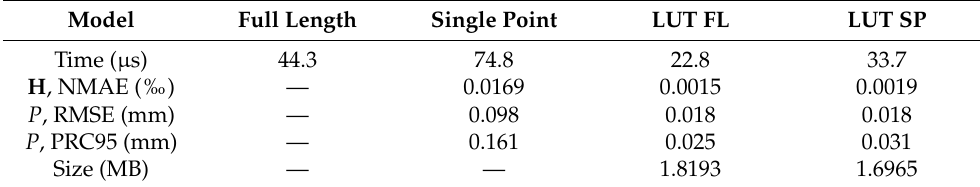
Table 1. Model comparison, based on a simulation of a 10mm-long sensor placed at 100,000 random positions and orientations within the tracking region. The normalised mean absolute error (NMAE) of the magnetic field, H , is averaged between the eight equal emitter coils, and the associated error in terms of position accuracy, P , is reported. The error introduced by the single-point approximation is calculated with respect to the full-length model. Each LUT is evaluated against the correspondent analytical model. Model Full Length Single